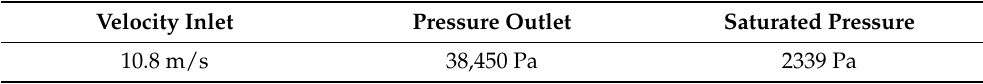
Table 5. Operating Table 5. Operating conditions.